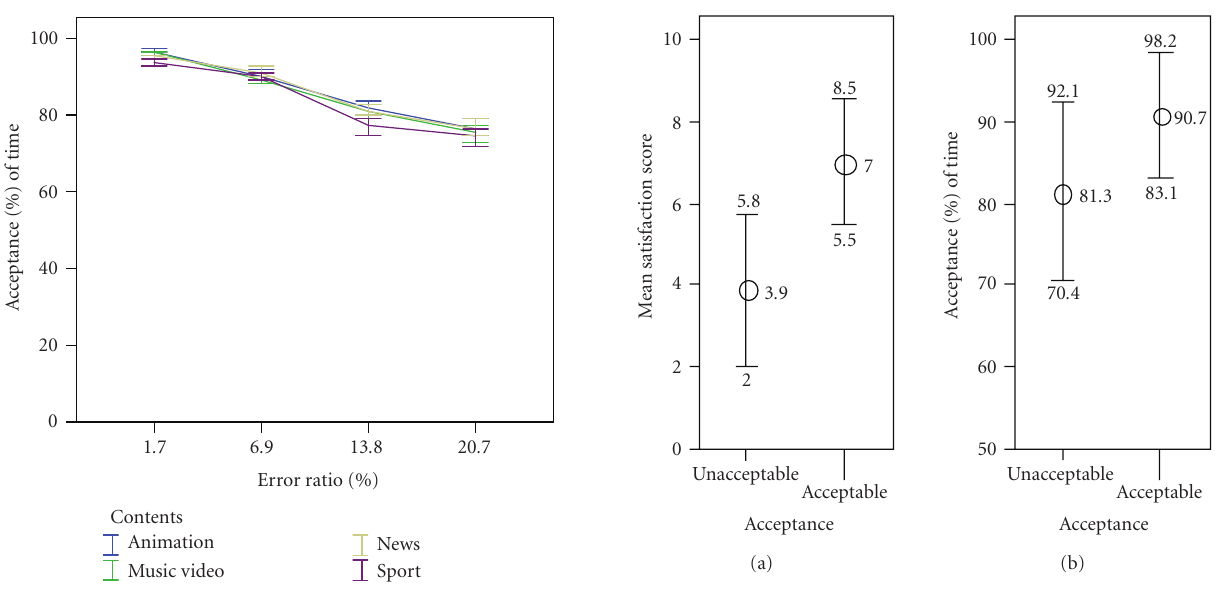
Figure 6: Acceptance percentage of time for all contents. Error bars show 95% CI of mean.